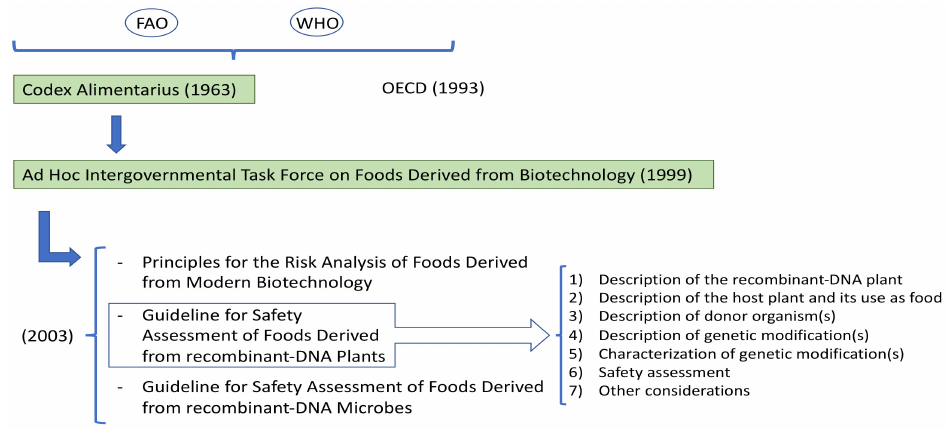
Figure 2. Development of standards and recommendations for products resulting from